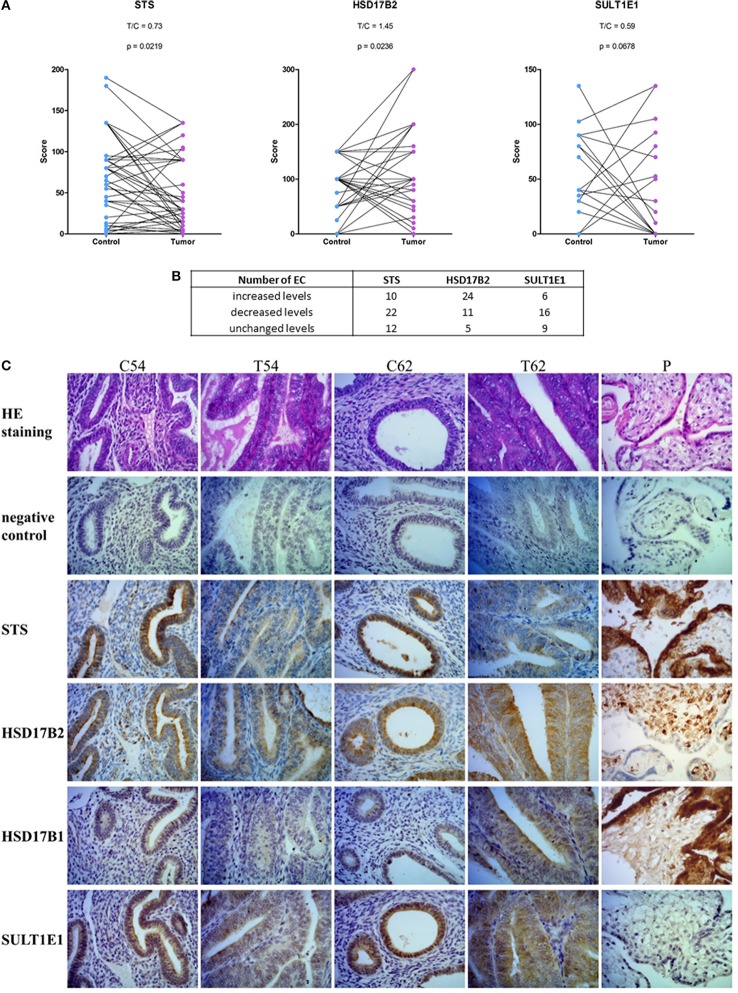
Immunohistochemical staining for STS, HSD17B2, HSD17B1, and SULT1E1 in endometrial cancer. (A) Before-and-after graphs show scoring for STS, HSD17B2, and SULT1E1 in control endometrium (Control) and the corresponding cancer endometrium (Tumor). (B) Table with number of samples with increased, decreased or unchanged levels of protein in tumor tissue compared to adjacent control endometrium. (C) representative staining of adjacent control endometrium (C) and cancerous tissue (T) for STS, HSD17B2, HSD17B1, and SULT1E1 (samples 54 and 62), and placenta (P) as a positive control. Samples were stained with hematoxylin and eosin (HE staining) and with specific antibodies against STS, HSD17B2, HSD17B1, and SULT1E1. 400 × magnifications are shown.